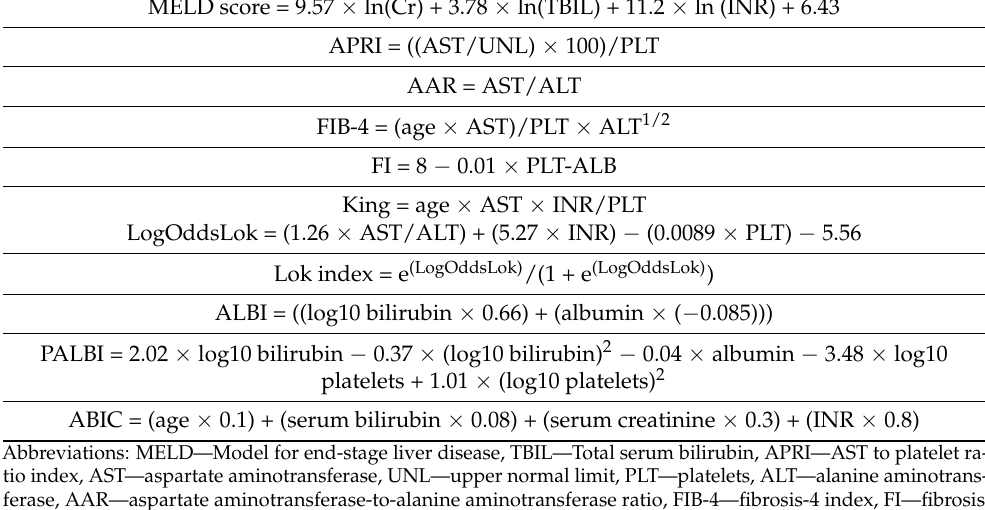
Table 1. Calculation of non-invasive